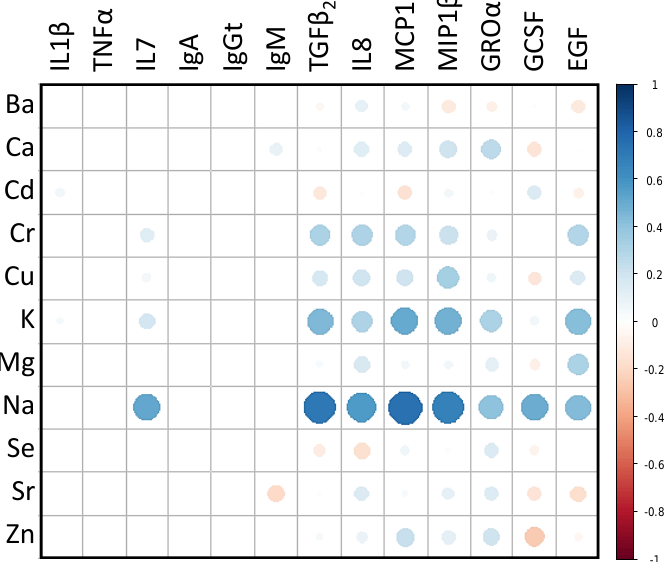
in the levels of TGFβ 2 , IL8 and MCP1 in milk depending on the presence of BPA (Figure 5 and Supplementary Table S10). The median (IQR) concentrations of TGFβ 2 , IL8 and MCP1 were double or higher in samples where total BPA was not detected (2.48 µg/L Figure 4. Spearman’s rank correlation matrix between the main and trace elements concentrations and the content of immunological compounds in milk samples. Blue colours show positive correlations, while reddish hues show negative correlations; dots with larger diameters show stronger correlations. The colour intensity of the dots shows the nature of the correlation: dark blue indicates a perfect positive correlation ( ρ = 1) and dark red indicates a perfect negative correlation ( ρ = − 1).